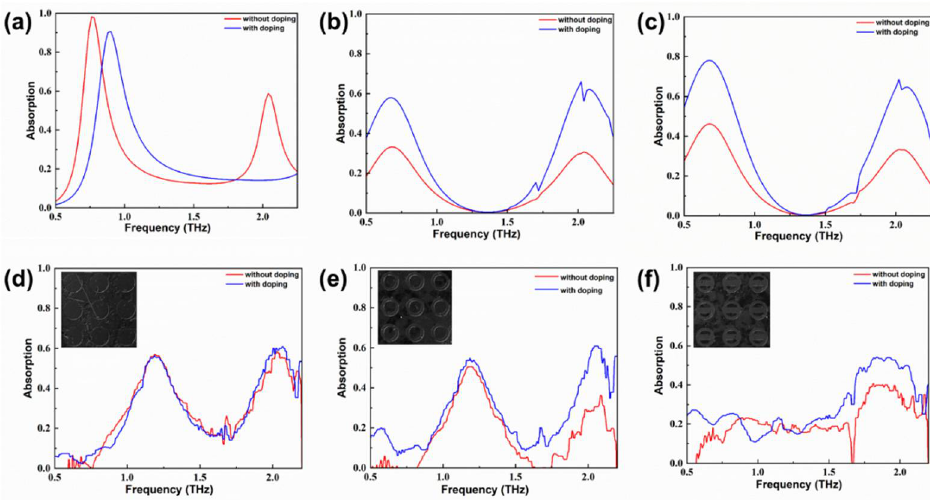
Figure 6. Simulated absorption spectra before and after doping process for ( a ) disk pattern, ( b ) ring pattern, and ( c ) circled minus pattern. Tested absorption spectra of undoped absorbers and doped absorbers for ( d ) disk pattern, ( e ) ring pattern, and ( f ) circled minus pattern with the optical image in the upper left corner.